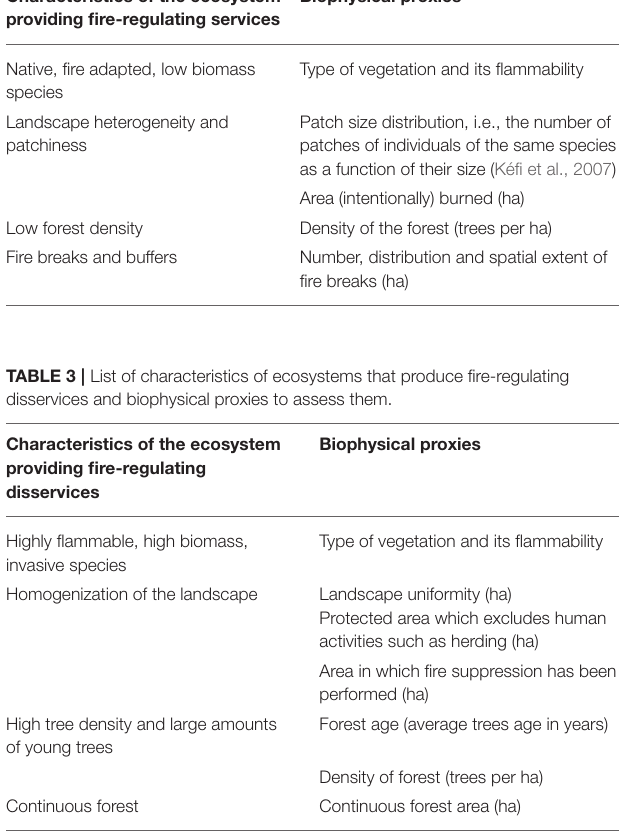
TABLE 2 | List of characteristics of ecosystems that provide fire-regulating services and biophysical proxies to assess them. Characteristics of the ecosystem providing fire-regulating services Native, fire adapted, low biomass species